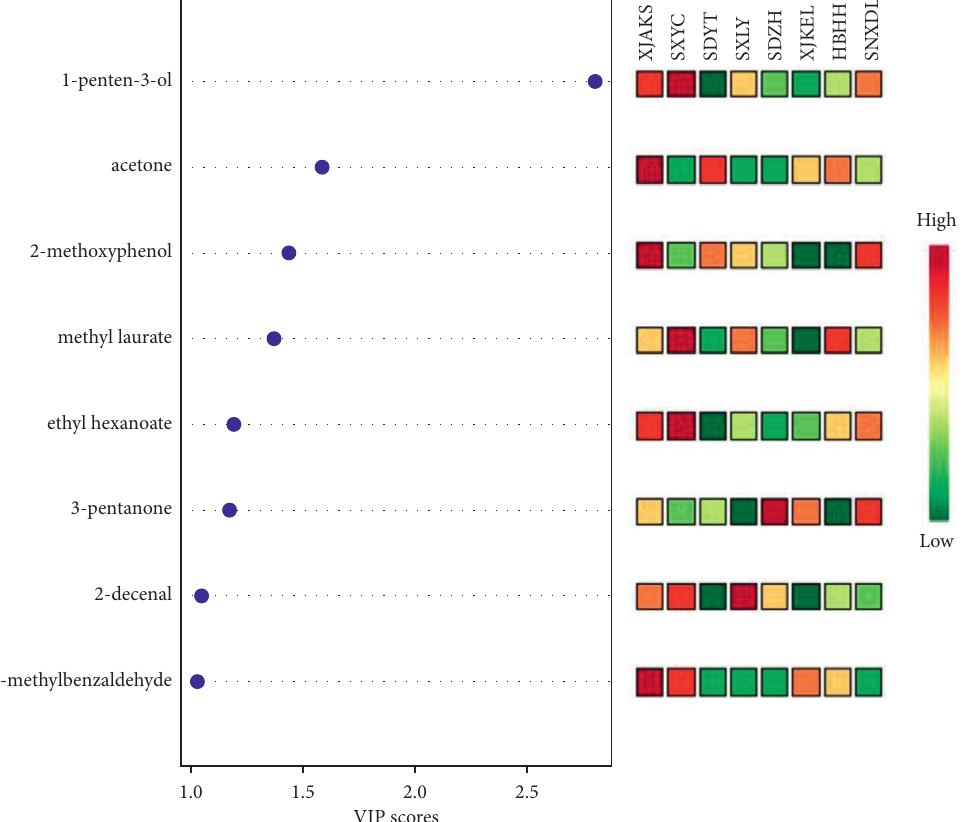
Figure 6: VIP scores of the differential compounds in winter jujubes.